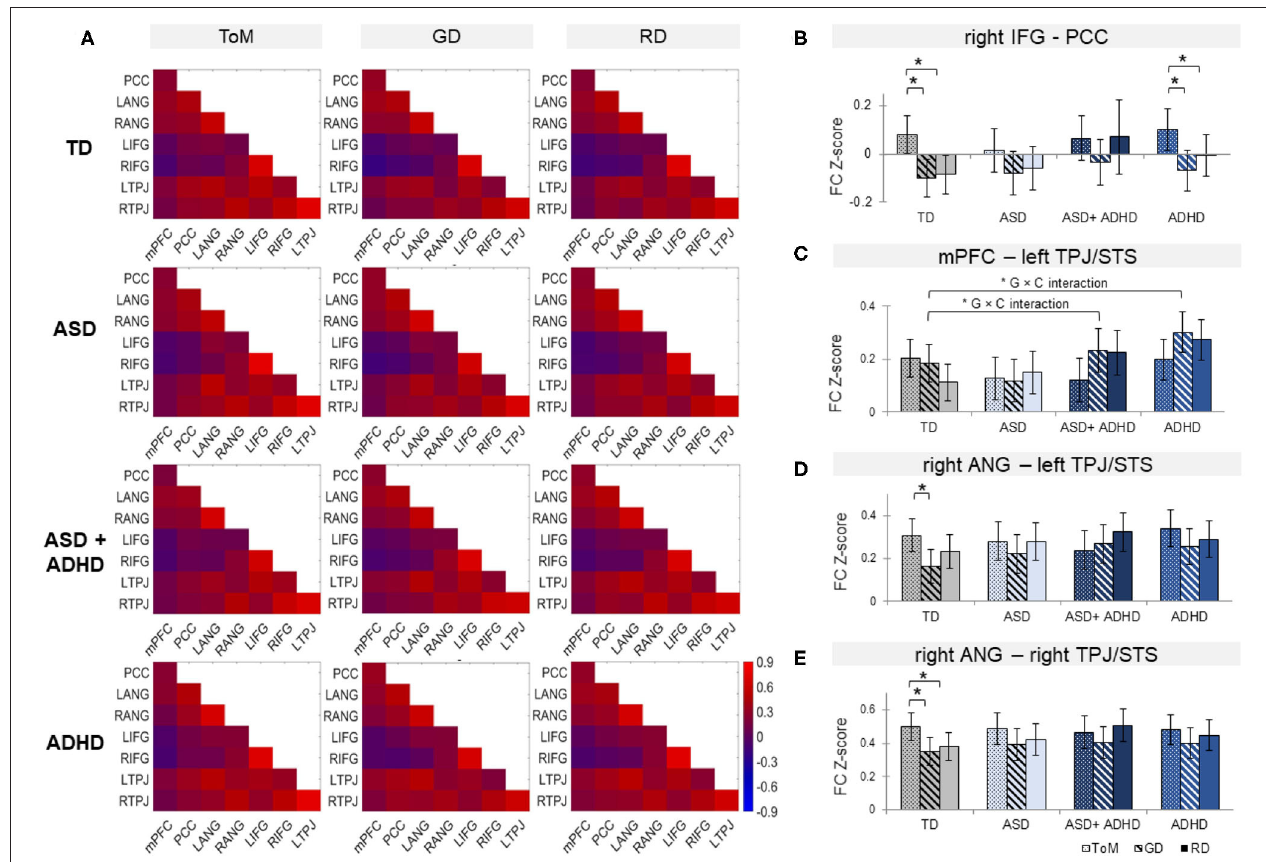
FIGURE 4 | (A) Functional connectivity (FC) matrices within each group for theory of mind (ToM), goal-directed (GD), and random (RD) movement among medial Prefrontal Cortex (mPFC), posterior cingulate cortex (PCC), bilateral angular gyrus (ANG), bilateral inferior frontal gyrus (IFG), and bilateral temporoparietal junction (TPJ), combined with superior temporal sulcus (STS). Bar graphs of FC for right IFG-PCC (B) , mPFC-left TPJ/STS (C) , right ANG with left (D) , and right TPJ/STS (E) by group and condition. *G × C represents significant group by condition interaction. Error bars represent 95% confidence interval. TD, typically developing controls; ASD, autism spectrum disorder; ADHD, attention-deficit/hyperactivity disorder. * p < 0.05 with false-discovery rate multiple comparison correction.